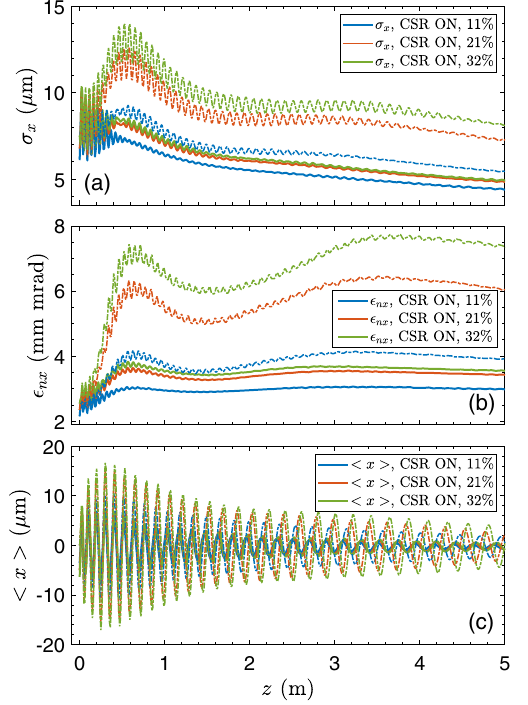
FIG. 22. Plots of (a) RMS beam envelope, (b) normalized emittance, and (c) horizontal beam centroid along the plasma source. In the figure legends, 11%, 21%, and 32% indicate the emittance growth by CSR effect before entering the plasma source from the initial emittance of 1.936 mm mrad. Solid lines are the case without adjusting the electron beam centroid and angle before injection to the plasma wakefield, whereas the dashed lines are the cases with adjustment.